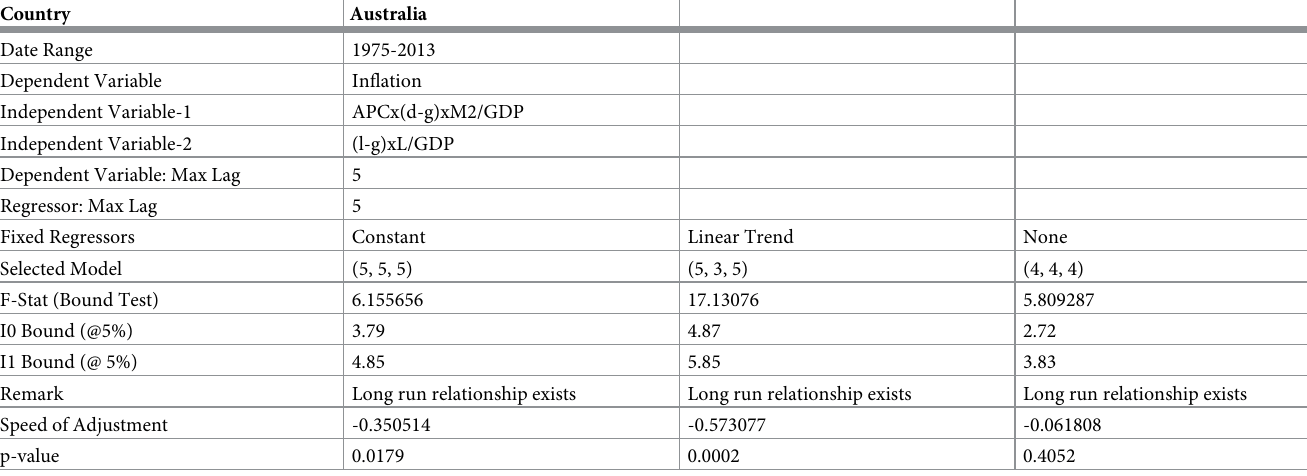
Table 21. ARDL Bounds Testing for Australian data under proposed